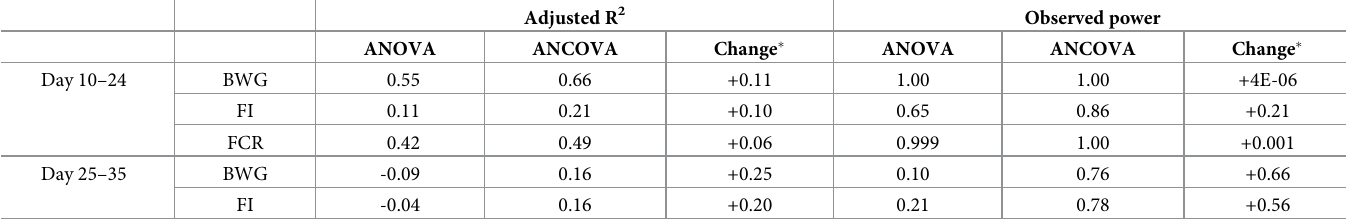
Table 3. Adjusted R 2 and observed power of performance data when analysed by a one-way ANOVA and ANCOVA during different phases for Experiment 1.